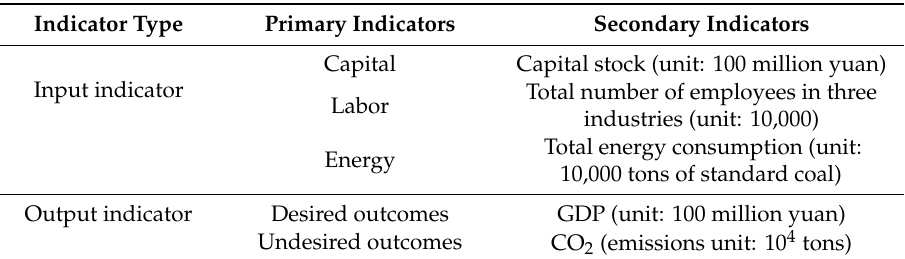
Table 2. Carbon emission e ffi ciency measurement index system.